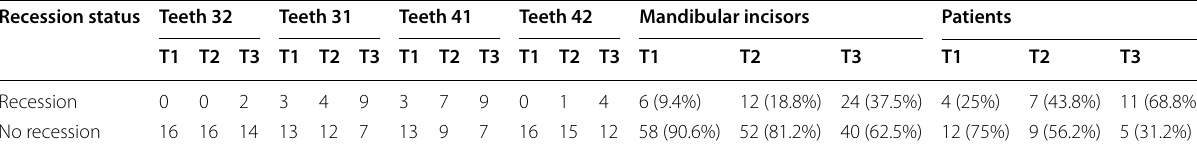
Table 3 Frequency of gingival recessions before treatment, after treatment and at follow‑up (64 teeth) Recession status Teeth 32 Teeth 31